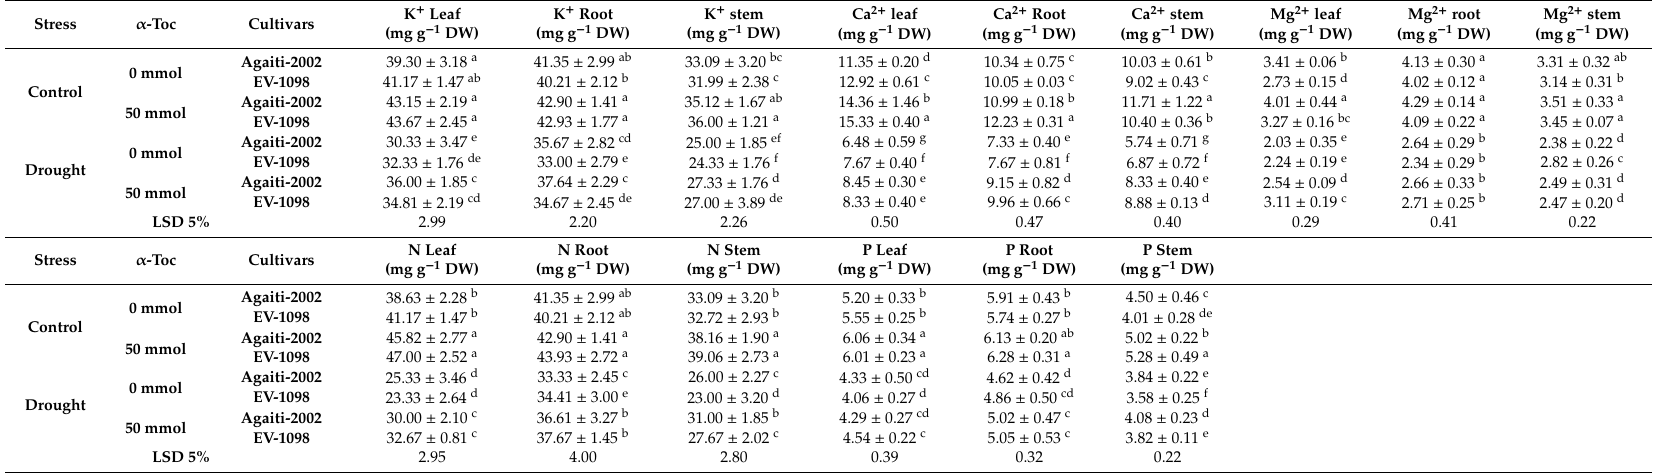
Table 5. Influence of foliar-applied α -Toc on tissue specific organic and inorganic minerals of two maize ( Zea mays L.) cultivars under non-stress and water-stressed conditions (mean ± SE; n =